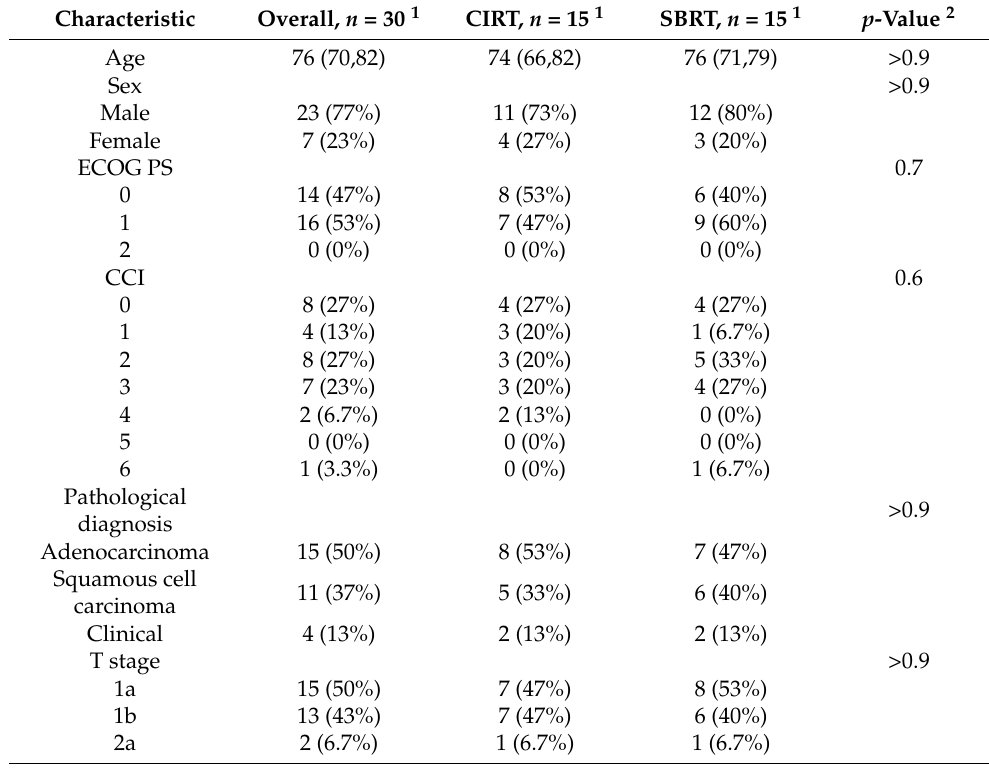
Table 3. Patient characteristics of the matched cohort ( n =